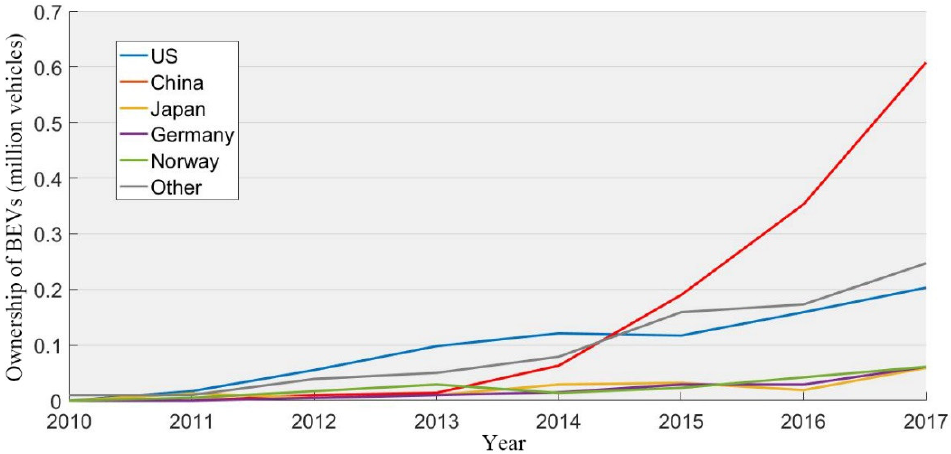
Figure 1. The sales of electric vehicles and battery hybrid vehicles in the world.